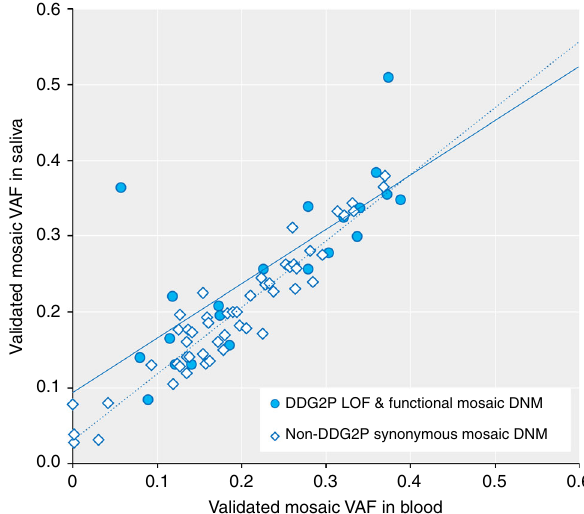
Fig. 3 Summary of validation results for de novo mutations. Comparison of the variant allele fraction (VAF) from exome sequencing versus from ultrahigh-depth sequencing for candidate DNMs, separated into validation classes: constitutive DNM (red), mosaic DNM (blue) and false positive (green). Validation data from both saliva and blood samples are included where available. The correlation between exome and validation VAFs ( R 2 = 0.49) includes only mosaic